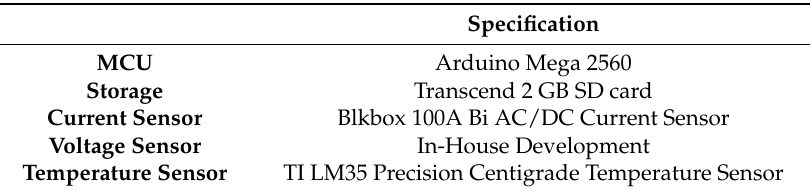
Figure 3. Operation concept of power transmission during a day. Table 1. Specifications of the photovoltaic power management system (PPMS).